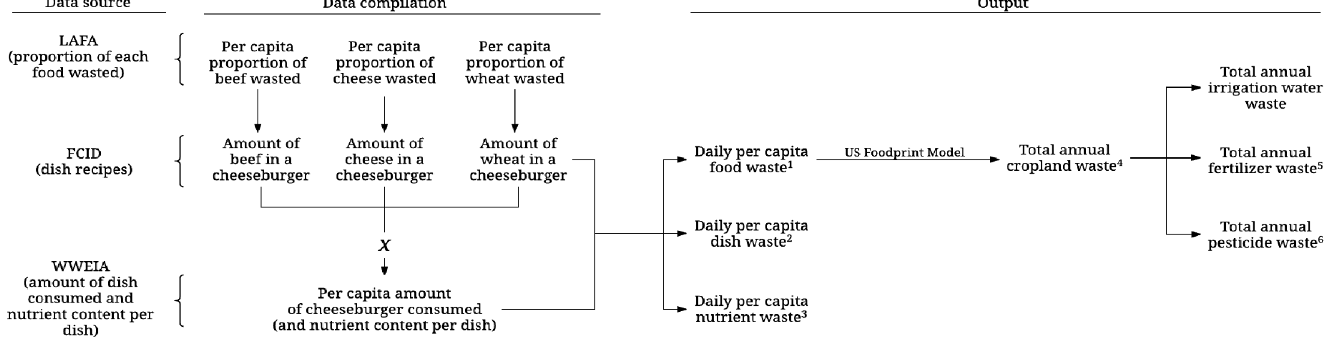
Fig 1. Data sources, compilation and output. LAFA, Loss-adjusted Food Availability data series; FCID, Food Commodity Intake Database; WWEIA, What We Eat In America 1 Grains, dark green vegetables, red and orange vegetables, legumes, starchy vegetables, other vegetables. fruit, milk and yogurt, cheese and other dairy, soy milk, nuts, tofu, beef, pork, chicken, turkey, eggs, fish, plant oils, dairy fats, lard and tallow, and sweeteners. 2 All dishes; meat and mixed meat dishes (beef and beef mixed dishes; pork and pork mixed dishes; poultry and poultry mixed dishes; seafood and seafood mixed dishes; meat sandwiches, burgers, sausages, and hotdogs; bacon; and other meat dishes) eggs and egg dishes; dairy (milk and cream, cheese); soup; grains and mixed grain dishes (bread; breakfast cereal; pancakes, waffles, and French toast; pastas and grain mixtures; pizza and calzones; and grain-based desserts); nuts and seeds; fruits and vegetables in mixed dishes (whole fruit and mixed fruit dishes; fruit/vegetable juice; dark green vegetables; yellow and orange vegetables; tomatoes and tomato mixtures; legumes; other vegetables); potatoes and potato mixed dishes; margarine, table oils, and salad dressings; salty snacks; Mexican dishes; other foods and dishes. 3 Calories; total protein; total carbohydrates; added sugars; fiber; total and individual saturated fatty acids; total and individual monounsaturated fatty acids; total and individual saturated fatty acids; cholesterol; vitamins (A, B 1 , B 2 , B 6 , B 12 niacin, folate, choline, C, D, K, E); minerals (calcium, phosphorous, magnesium, iron, zinc, copper, sodium, potassium, selenium); and total and individual carotenoids. 4 All cropland, grains, fruits, vegetables, legumes, nuts, sweeteners, feed grains and oilseeds, hay, and cropland pasture. 5 Nitrogen, phosphorus, and